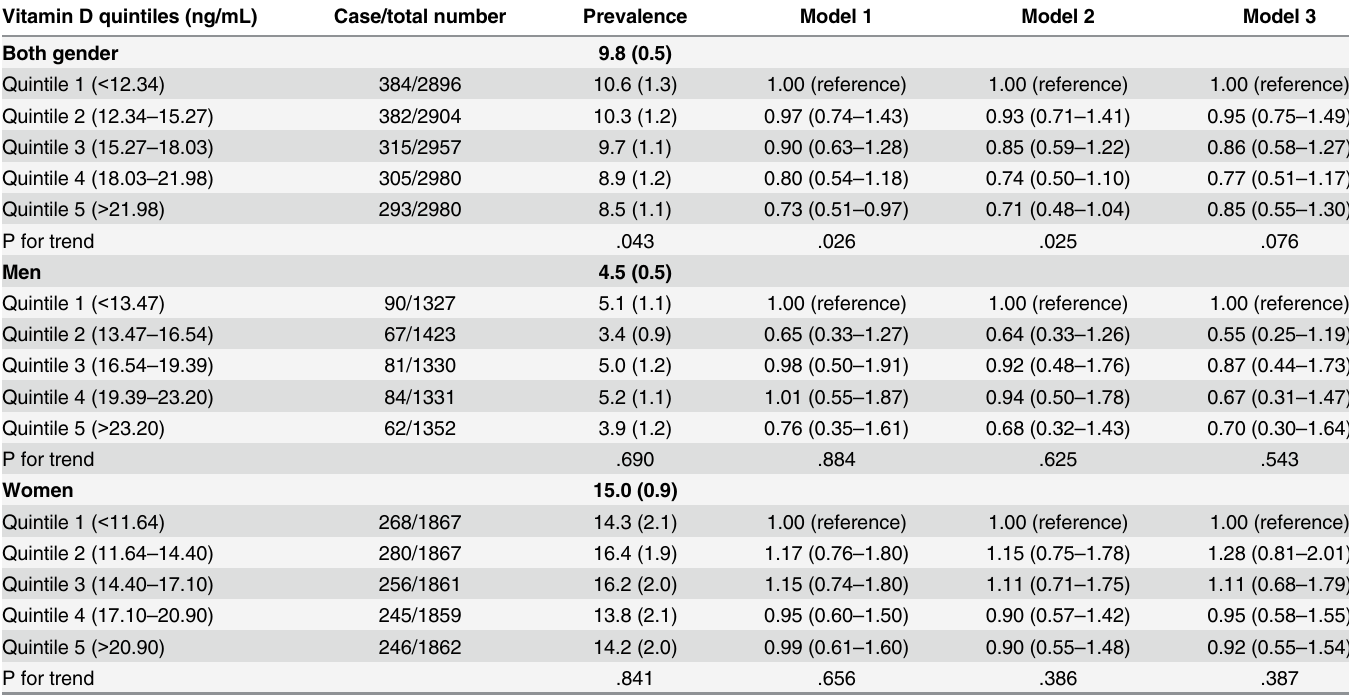
Table 4. Association between blood 25-hydroxyvitamin D and prevalence of dry eye syndrome (DES) among representative Korean adults. Vitamin D quintiles (ng/mL)